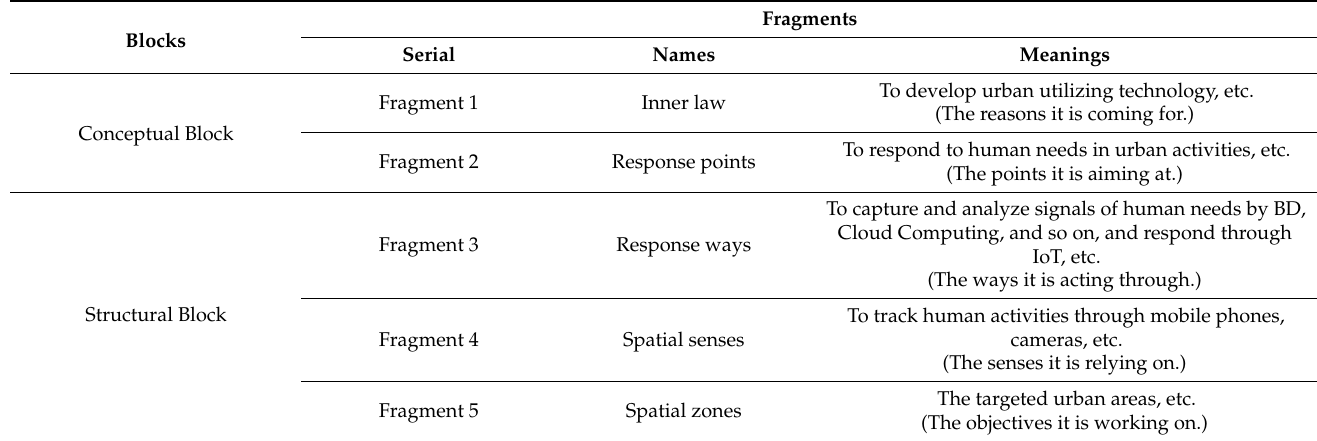
Table 3. The instructions of the blocks and fragments for the DNA Subchain α .